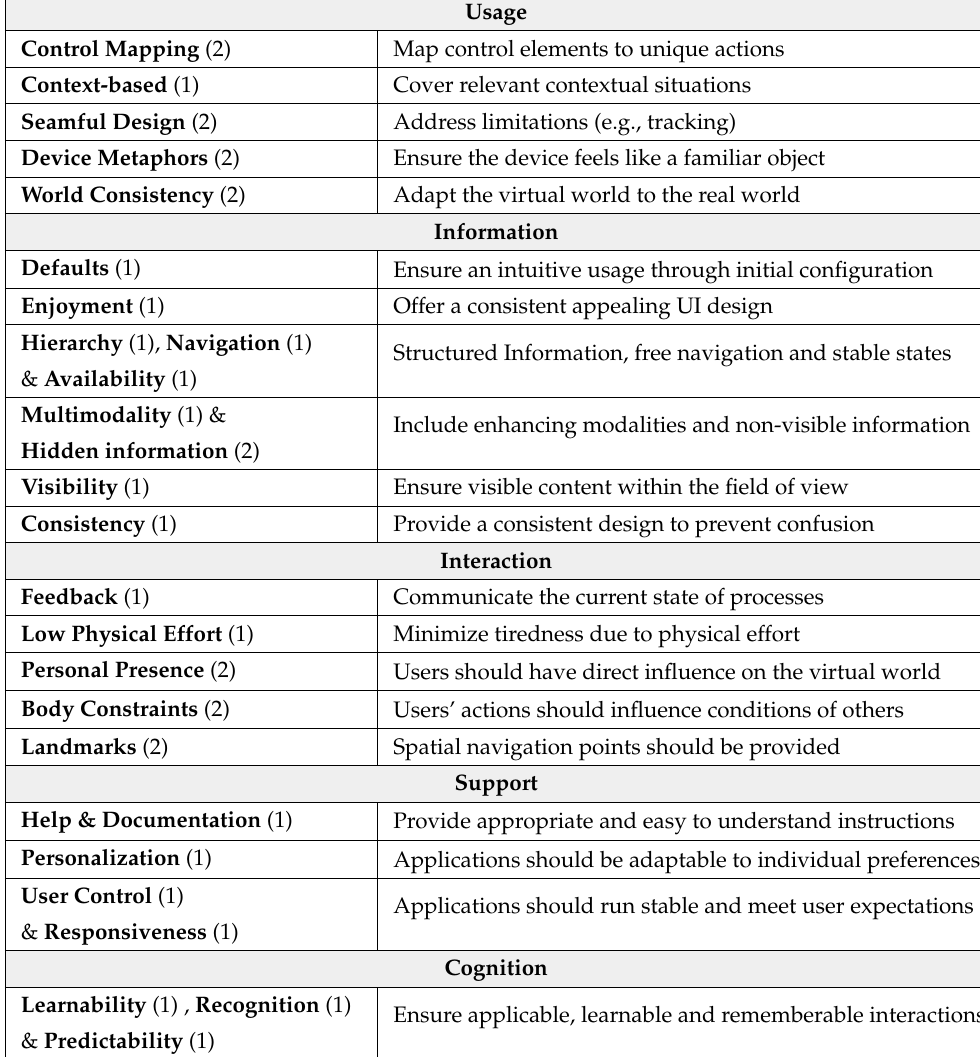
Table 1. Initial design pattern